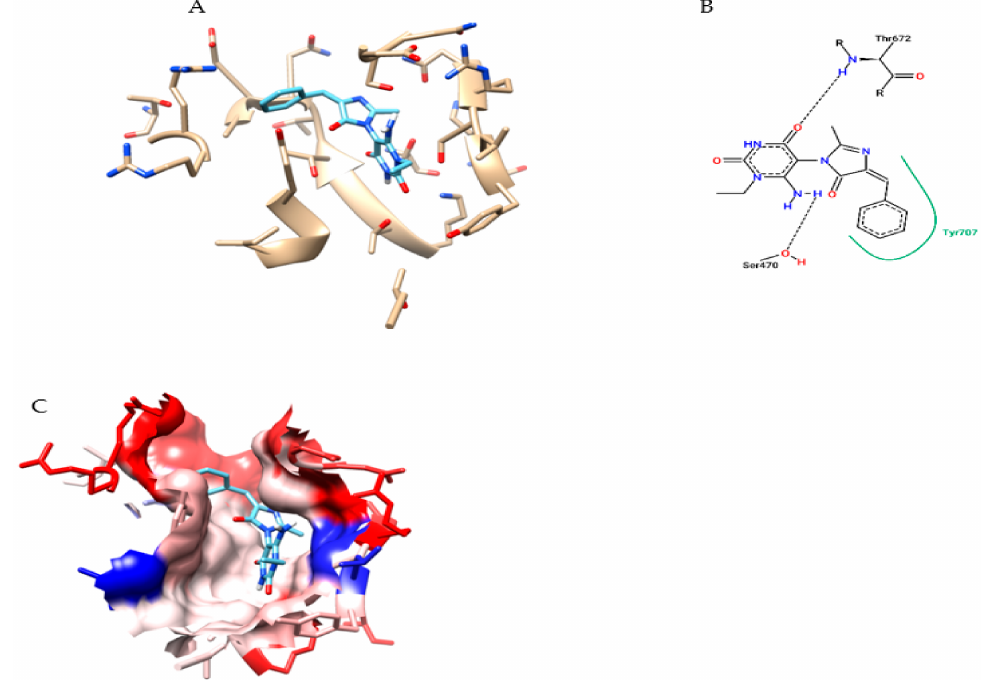
Figure 6. Compound 12 interaction with PBP protein, ( A ) 3D interaction, ( B ) hydrogen bond formation, ( C ) Hydrophobic interaction (represented by blue color).